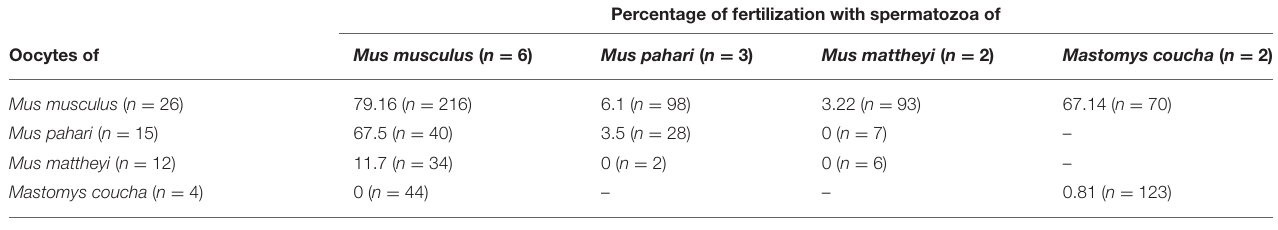
TABLE 3 | Results of cross in vitro fertilization (with cumulus and without cumulus cells).